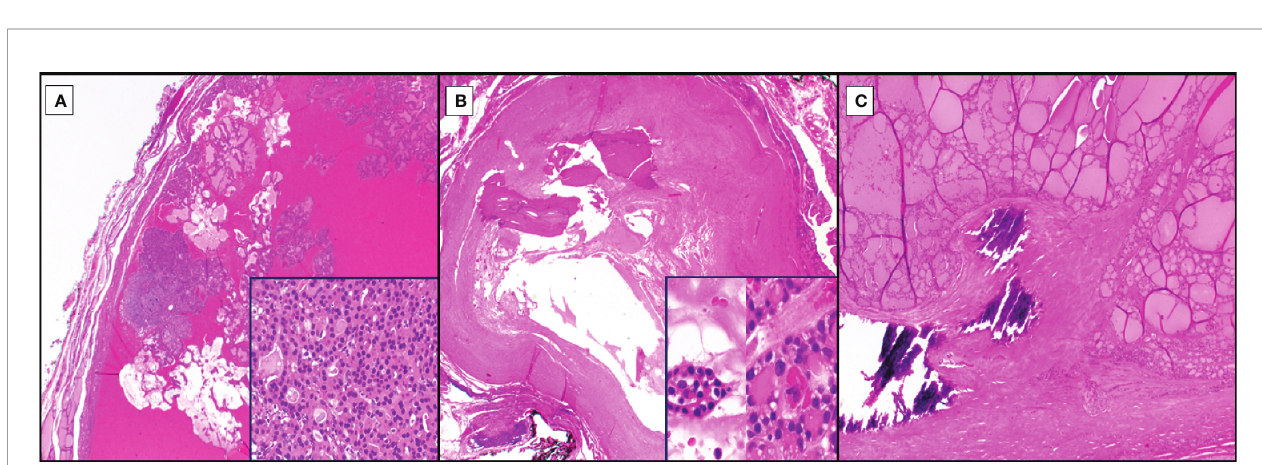
FIGURE 2 | Reactive Changes in Hürthle Cell Neoplasia. Among the diverse reactive changes seen with Hürthle cell neoplasia (hematoxylin and eosin stain), especially post traumatic, are cysti fi cation ( A , 20X magni fi cation), ossi fi cation ( B , 20X magni fi cation), and capsular irregularity with coarse calci fi cation ( C , 40X magni fi cation). Cystic changes due to hypoxia-related cellular drop out lead to papillary architectural formations at low power, lacking fi brovascular cores (A) but retaining Hürthle cell morphology and typically at least focal follicular architecture ( A , inset, 1000X magni fi cation). Exquisite hypoxia sensitivity can lead to complete ossi fi cation (B) , post-traumatic, of Hürthle cell tumors, occasionally with no residual cells or with rare clusters that may exhibit Hürthle cell features with associated nuclear atypia ( B , inset, 1000X magni fi cation). An additional feature, especially in tumors with thicker capsules, is intracapsular so-called “ coarse ” or “ egg shell ” calci fi cations which can distort the lesional growth pattern at the periphery and conferring a pseudoinvasive growth pattern (C) .